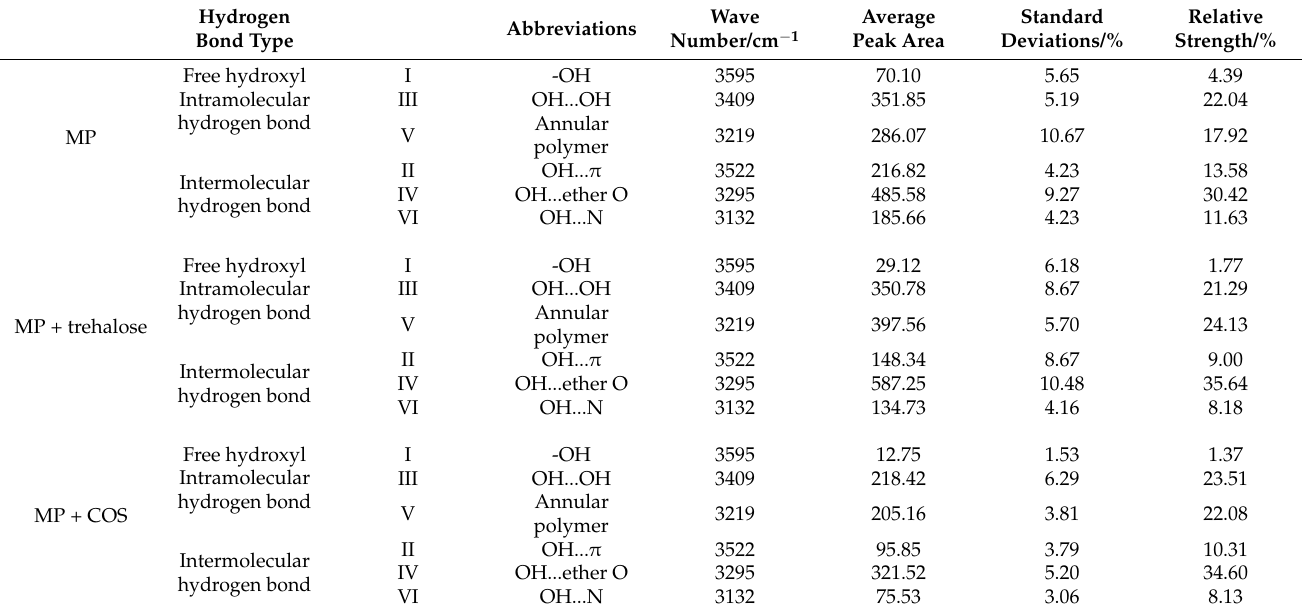
Table 2. The fitting results of various kinds of hydrogen